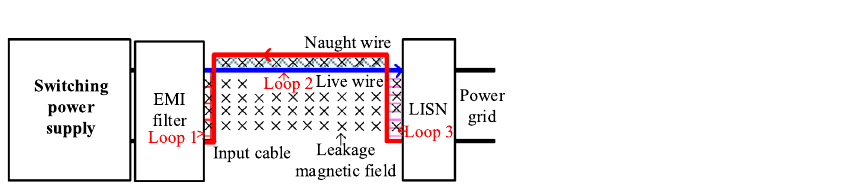
Figure 24. Schematic diagram of the negative coupling structure.